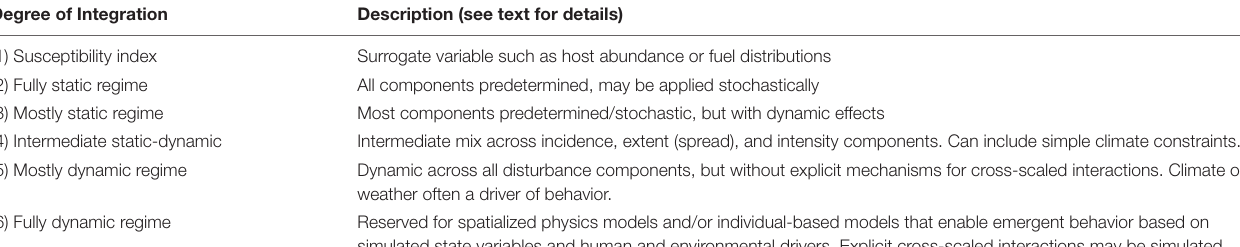
TABLE 4 | An index reflecting the relative degree of process integration applied for a given disturbance type and more complete description, with index values corresponding to the numbers applied within disturbance type columns in Table 3 . Degree of Integration Description (see text for details)